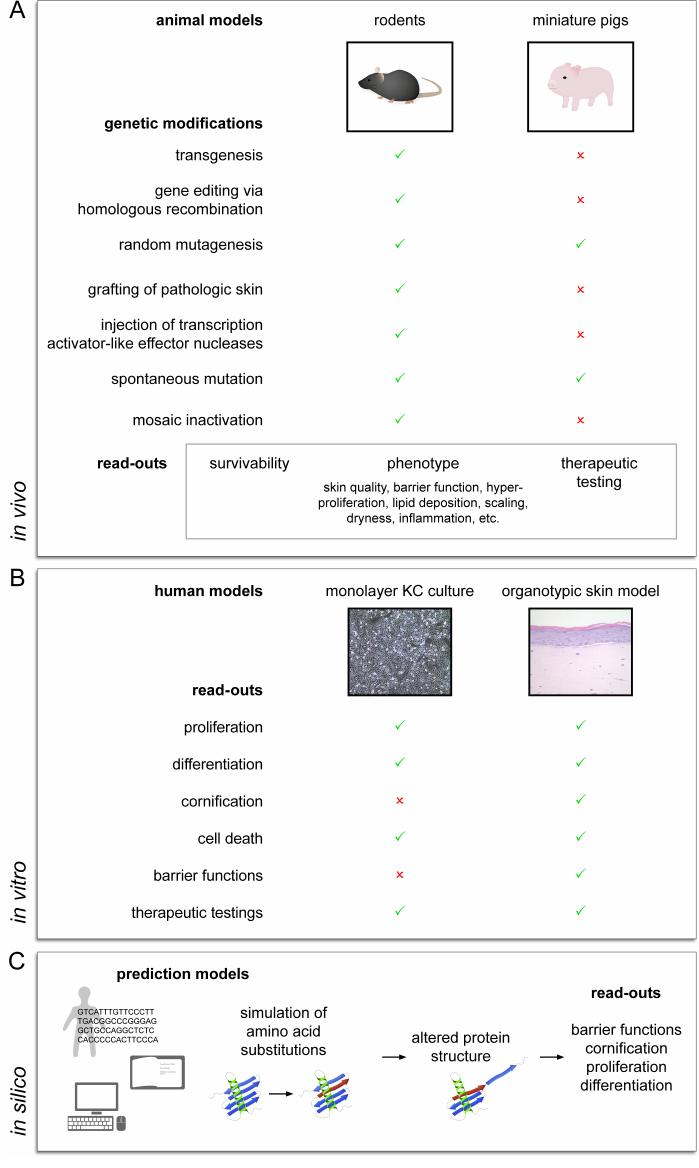
Figure 1. Schematic overview on experimental approaches for the study of hereditary disorders of cornification ( A ). Different genetic modifications are used to introduce cornification defects in animal-based models. Pathologic manifestations are assessed in terms of survivability, phenotypic changes, and response to therapy. ( B ) For in vitro models, human patient samples or primary human keratinocytes after target gene knockdowns are investigated in monolayer keratinocyte culture and three-dimensional organotypic skin models. ( C ) Computational methods are based on detection and characterization of sequence variants identified in patients and evaluation thereof in simulation and prediction